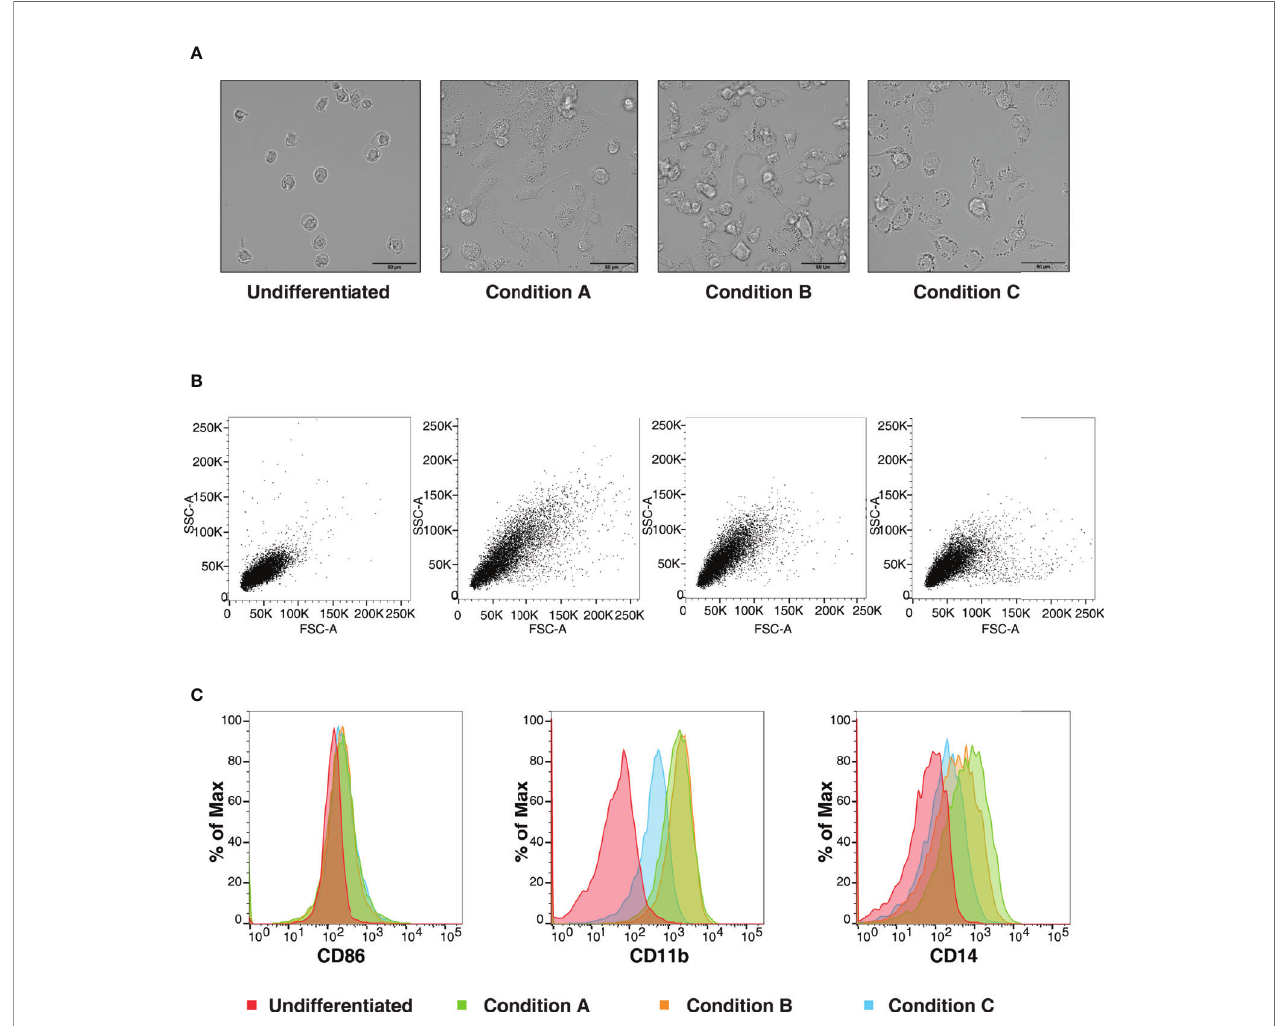
FIGURE 1 | Changes in cell morphology and surface receptor expression are dependent on PMA- mediated differentiation conditions. (A) Representative bright- fi eld images (Scale bar:50 m m) (B) Representative forward and side light scatter plot (C) Representative fl ow cytometric analysis of THP-1 cells stained using anti- CD86, CD11b or CD14 of THP-1 cells differentiated with varying concentration of PMA (Condition A: 50ng/ml PMA 72h, +48h rest, Condition B: 50ng/ml PMA overnight, + 48h rest and Condition C: 5 ng/ml PMA 48h, +3h rest). Data is representative of at least three independent